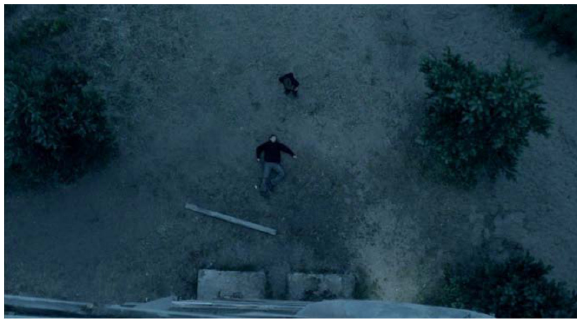
Figure 15. The Return (2003).